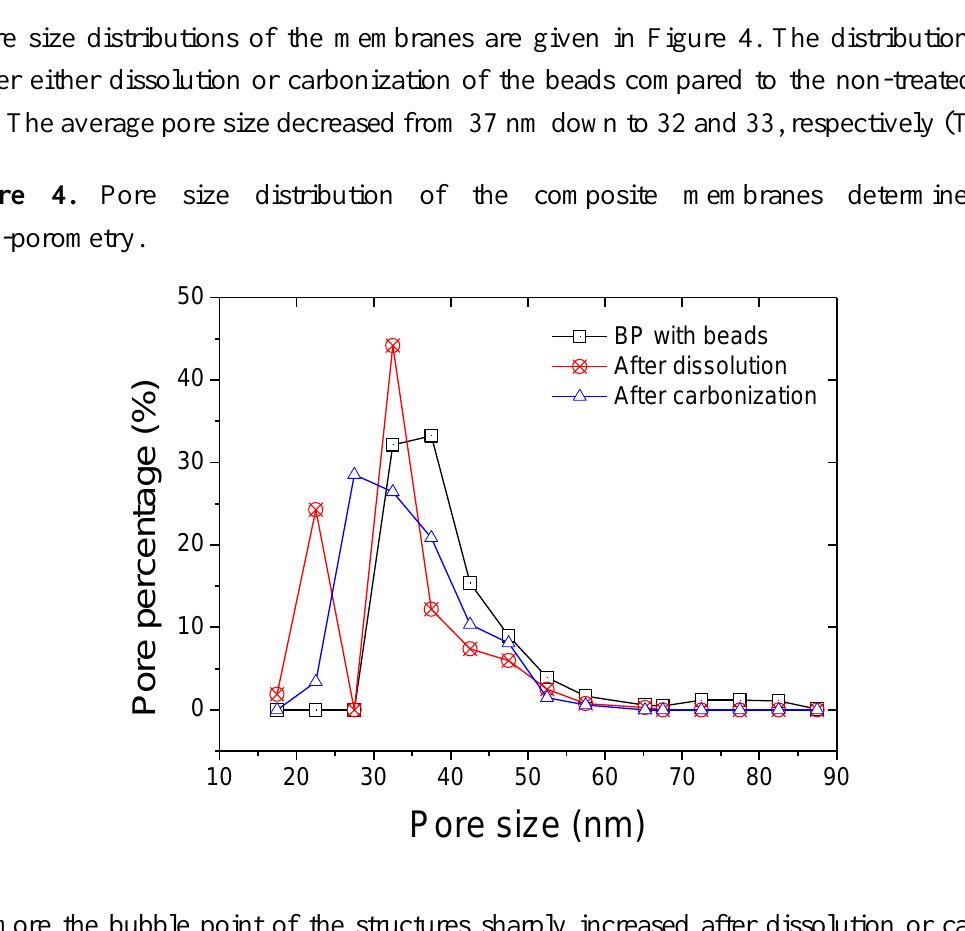
Length of the line (mm)